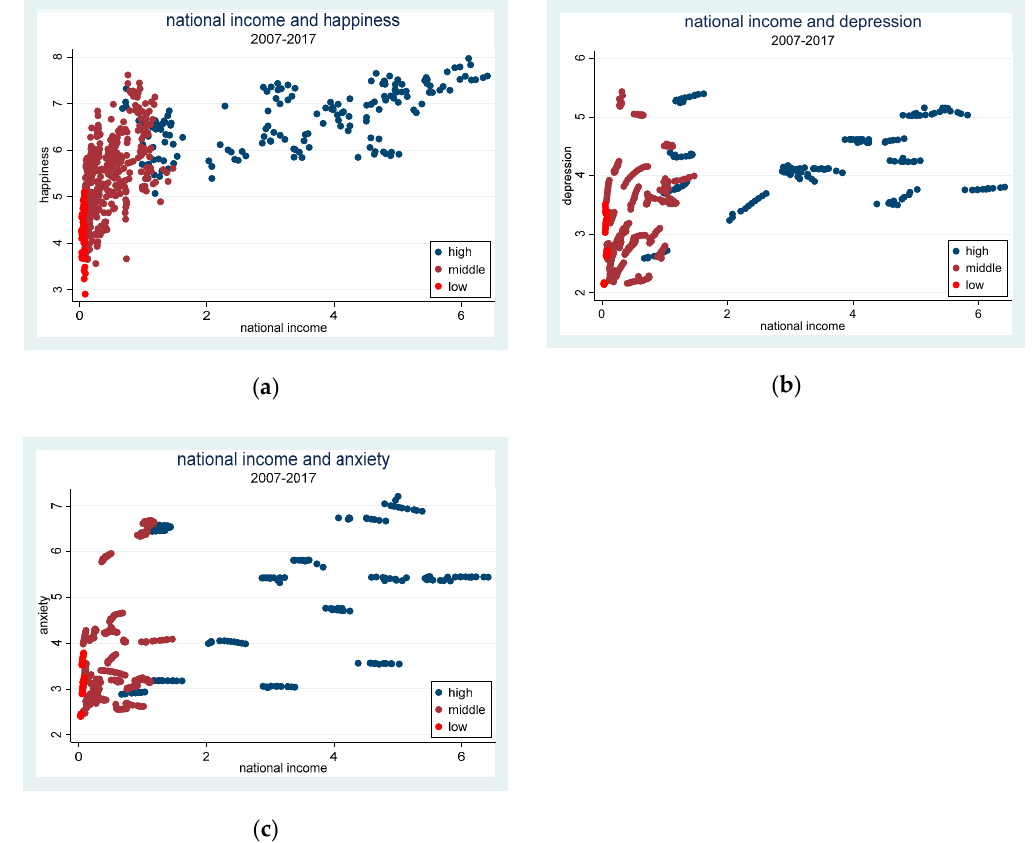
Figure 2. The relationship between national income and different types of mental health. ( a ) The relationship between national income and happiness. ( b ) The relationship between national income and depression. ( c ) The relationship between national income and anxiety. The sample period is from 2007 to 2017.